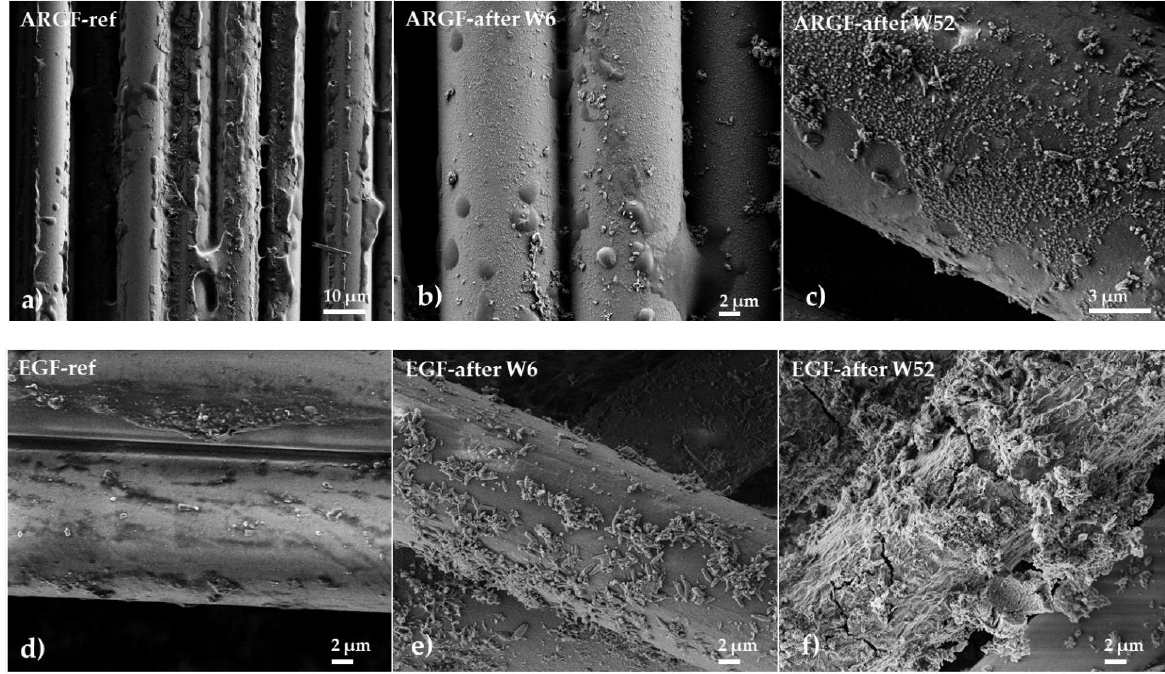
Figure 4. Surfaces of glass fibers after treatment in the Ca(OH) 2 solution: ARGFs: ( a ) reference sample, ( b ) after W6, and ( c ) after W52; EGFs: ( d ) reference sample, ( e ) after W6, and ( f ) after W52.